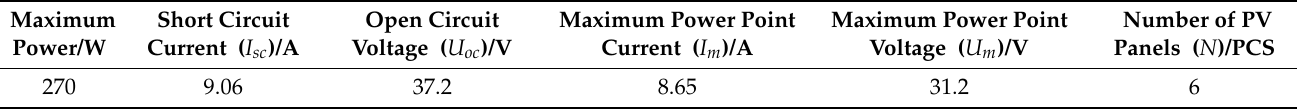
Table 1. Main parameters of PV panel.